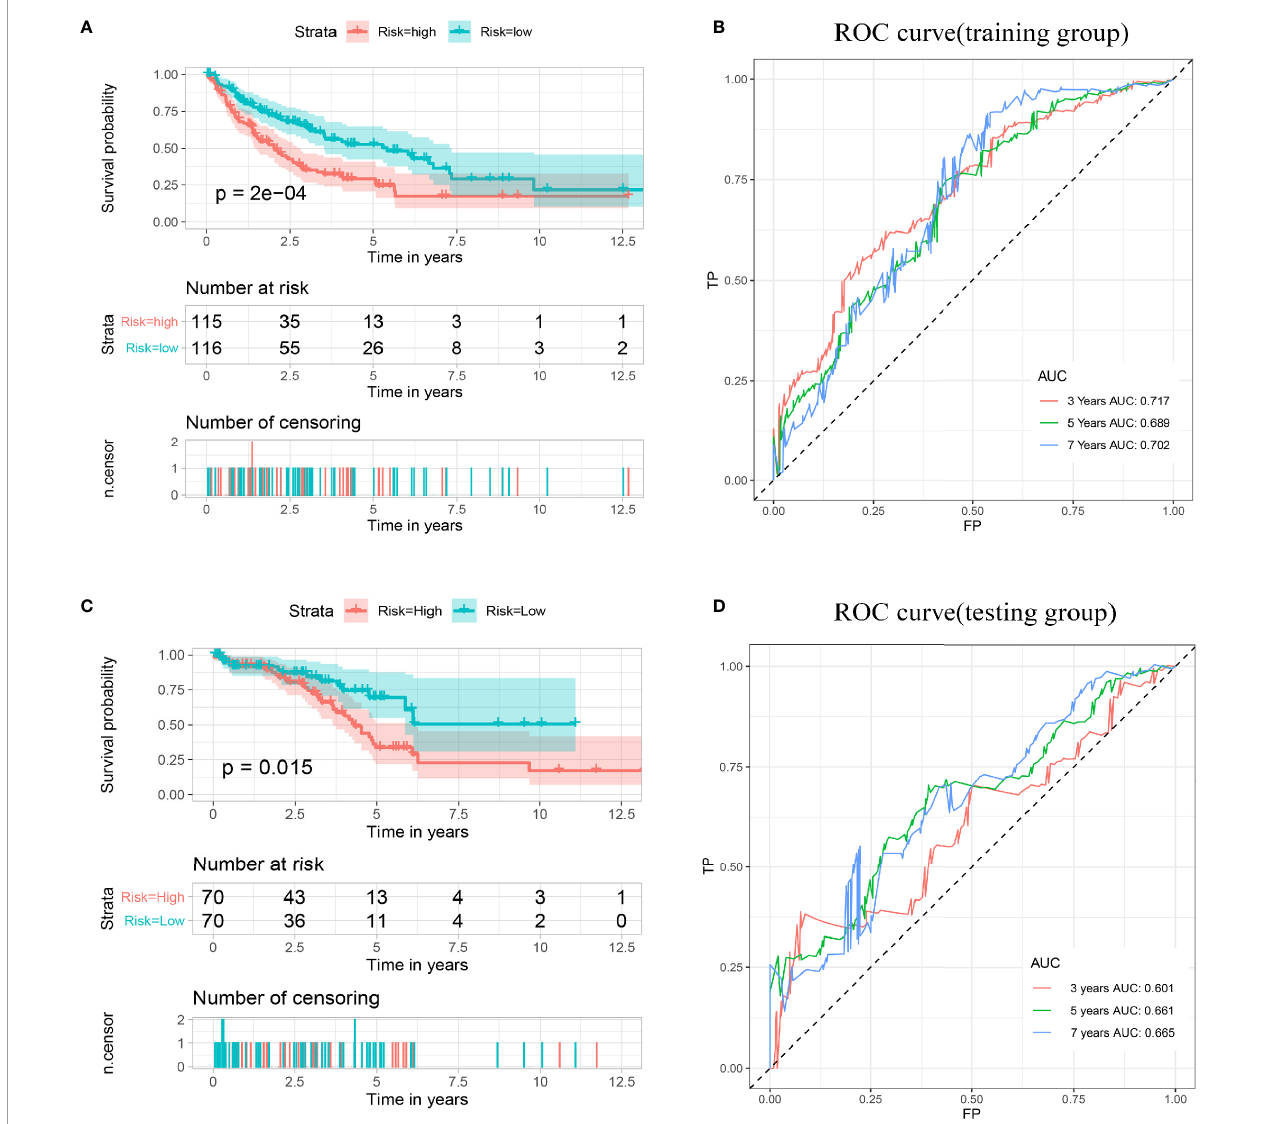
FIGURE 5 | Establishment and validation of a prognostic model related to DFS based on IMGRs. (A) The survival curve shows that the DFS status of high-risk and low-risk patients in the training cohort is different. (B) Receiver operating characteristic curve of the prognostic signature in the training cohort. (C) The survival curve shows that the DFS status of high-risk and low-risk patients in the validation cohort was different. (D) Receiver operating characteristic curves of the prognostic signature in the validation cohort. DFS, disease-free survival; IMRGs, iron metabolism-related